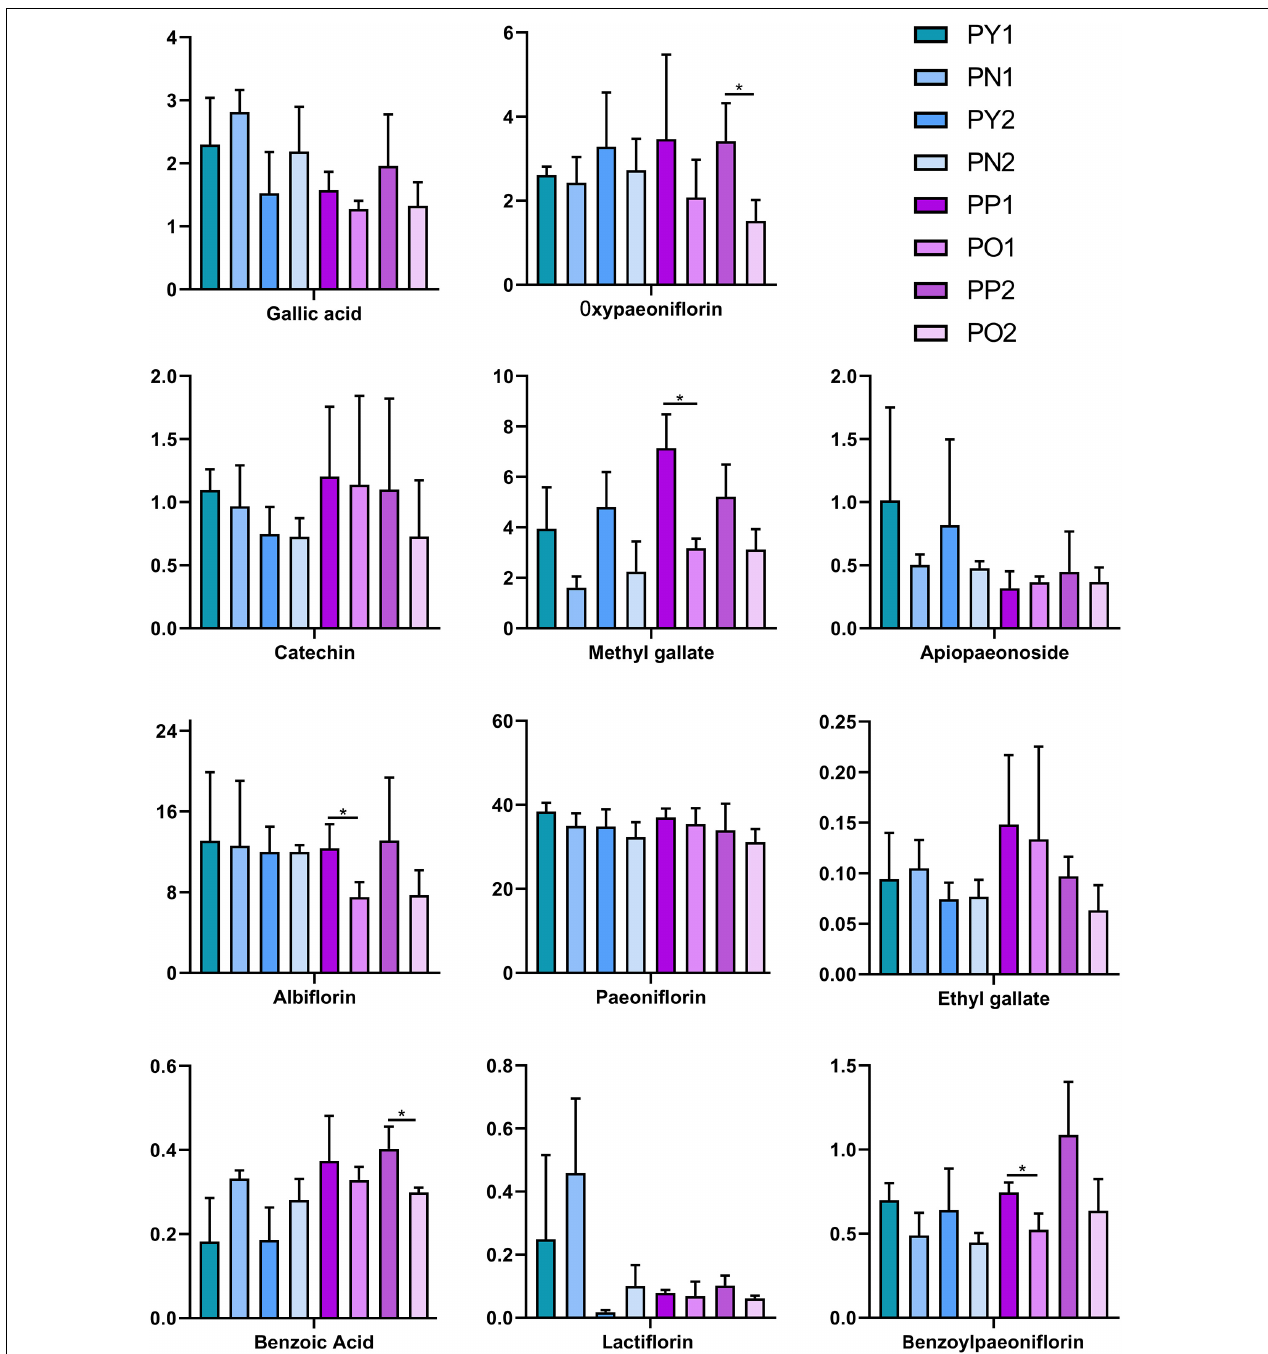
FIGURE 6 | Contents of 11 reference compounds in the divided parts with and without “pockmarks” of P. lactiflora roots. * p < 0.05.